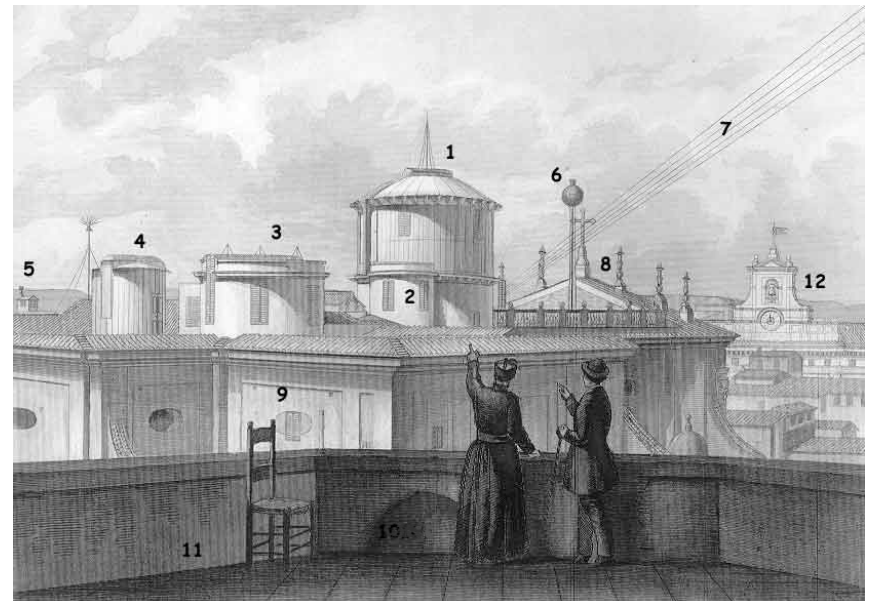
Figure 7. Observatory of the Collegio Romano in 1852. 1—Main observatory for the Merz equatorial telescope. 2—Access stairwell of the main observatory. 3—Elliptical observatory for the Ertel meridian circle. 4—Observatory for the Cauchoix telescope. 5—Electric turret observatory with the small spherical conductor. 6—Antenna with the wicker globe which, when released at noon, gave the signal for the firing of the cannon located on Castel S. Angelo (today the cannon is located on the Janiculum). 7—Bundle of electric cables for the transmission of signals from the meteorological sensors located on the Calandrelli Tower to the Meteorograph Recorder located in room below the main Observatory. 8—Back side of the tympanum of the Church of S. Ignazio with the long balustrade used as a practicable loggia for night observations. 9—Back side of the Church of St Ignatius. 11—Median terrace of the Calandrelli Tower. 12—Attic of Palazzo di Montecitorio, now the Chamber of Deputies. Source: author unknown, Public domain, via Wikimedia Commons. Accessed on 30 March